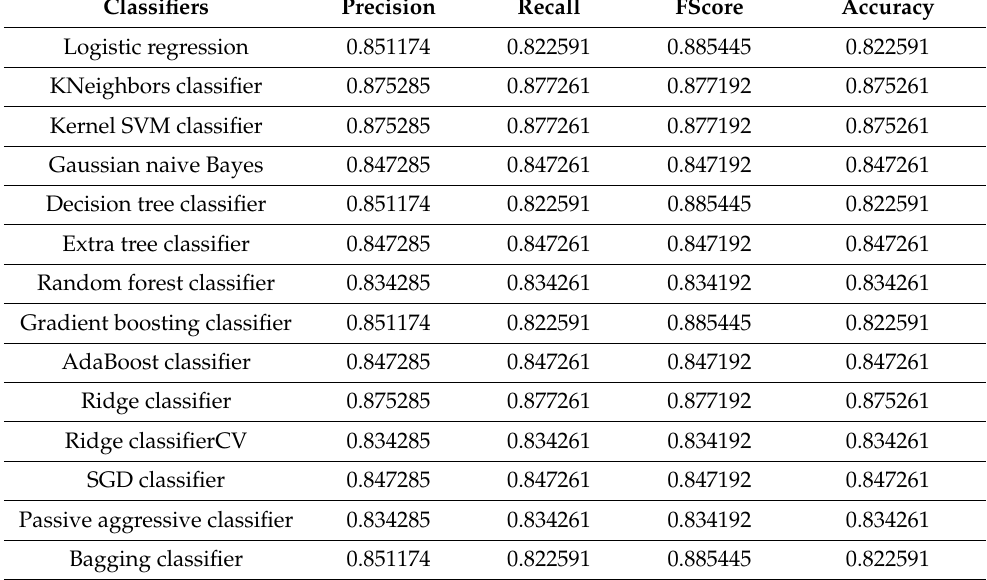
Table 17. AdaBoost classifier metrics before feature scaling.